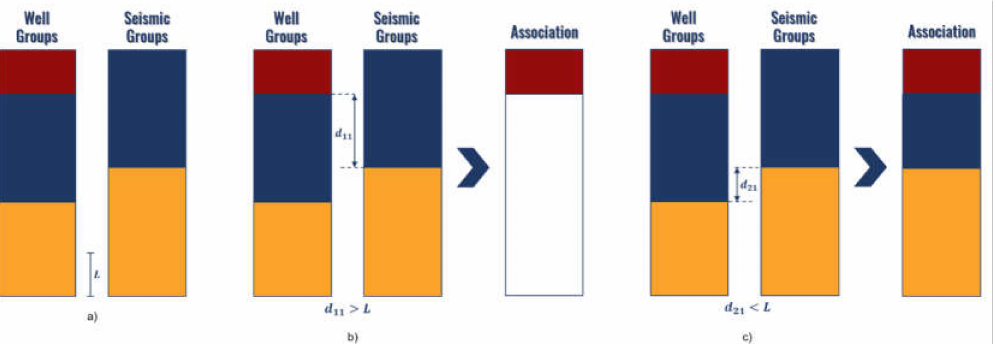
Figure 8. Exemplification of the association process evaluated from the top to the bottom of the well: ( a ) original clustering results, ( b ) association between the first limit of the well group and seismic group when the distance between group limits is bigger than a threshold L , ( c ) association between the second limit, which is now smaller than L